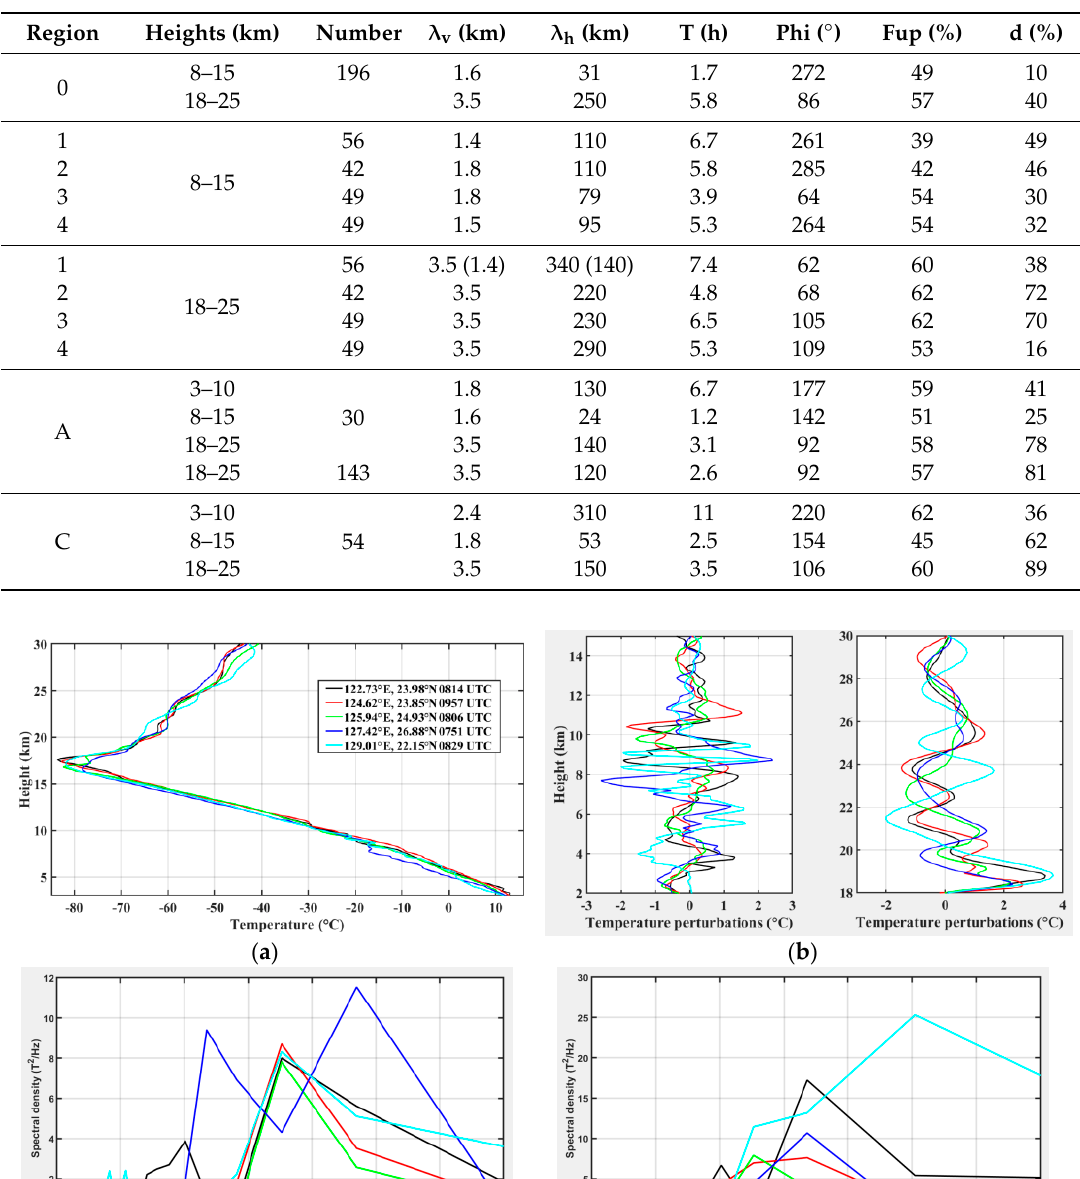
Table 1. Characteristics of dominant GWs using combined conventional methods (CCM) on simulated vertical profiles of horizontal wind and temperature on 7 August 12:00 UTC. Values are derived from peaks of wave parameter distributions. Region: location of vertical profiles; heights: altitude range; number: number of extracted profiles; λ v and λ h : vertical and horizontal wavelengths; T : intrinsic period; Phi : direction of horizontal wave propagation (clockwise from north), Fup : fraction of upward energy; d : degree of polarization. Region 0 (20 ◦ –26 ◦ N; 120 ◦ –172 ◦ E) is divided into four sub-regions from the TC eye (23 ◦ N, 123.2 ◦ E): 1 (upper left), 2 (upper right), 3 (lower right) and 4 (lower left).